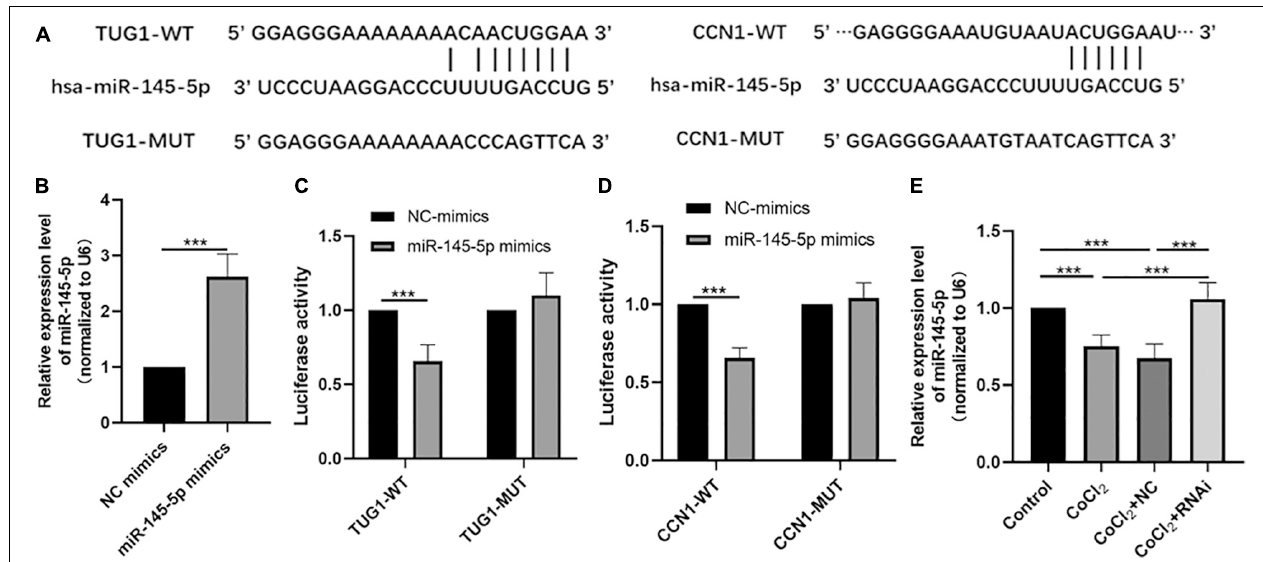
FIGURE 3 | MiR-145-5p interacts with TUG1 and CCN1. (A) The predicted binding sites between miR-145-5p and TUG1, and those between miR-145-5p and CCN1 from bioinformatic analysis using starBase interface. (B) The transfection efficiency and expression of miR-145-5p (mean ± SD, n = 5). *** P < 0.001. (C) Luciferase reporter assays of TUG1 and miR-145-5p (mean ± SD, n = 5). *** P < 0.001. (D) Luciferase reporter assays of miR-145-5p and CCN1 (mean ± SD, n = 5). *** P < 0.001. (E) MiR-145-5p expression level (mean ± SD, n = 5). *** P < 0.001.